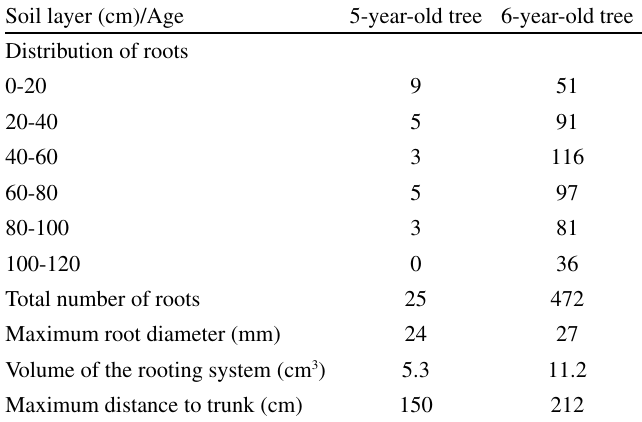
Table 4 - Root distribution, number and diameter observed during the experimental year for six-year-old Chétoui olive trees com- pared with measurements made on five-year-old